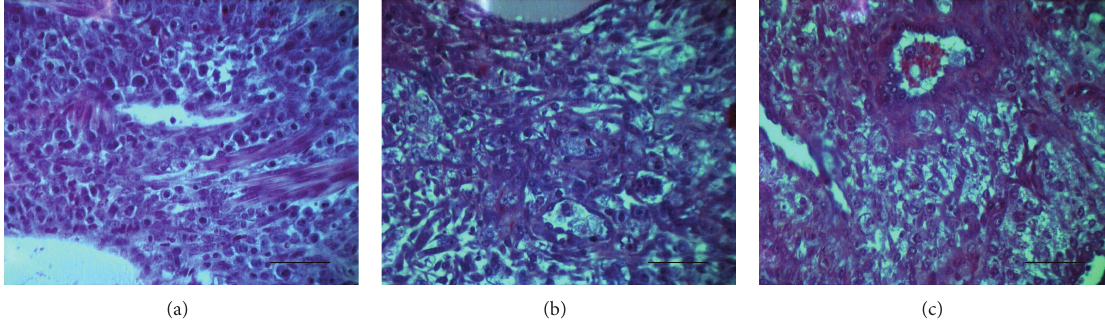
Figure 4: Histological analysis of decidual cells treated with Baicalin: (a) LPS group, (b) control group, and (c) Baicalin group. The bars represent 50 𝜇 m.